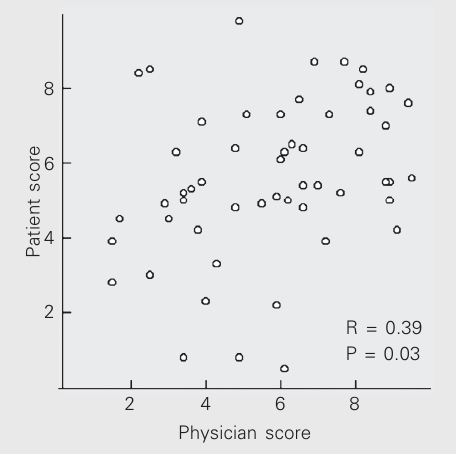
asthma exacerbation given by physicians and patients. Scores range from 0 (more severe) to 10 (less